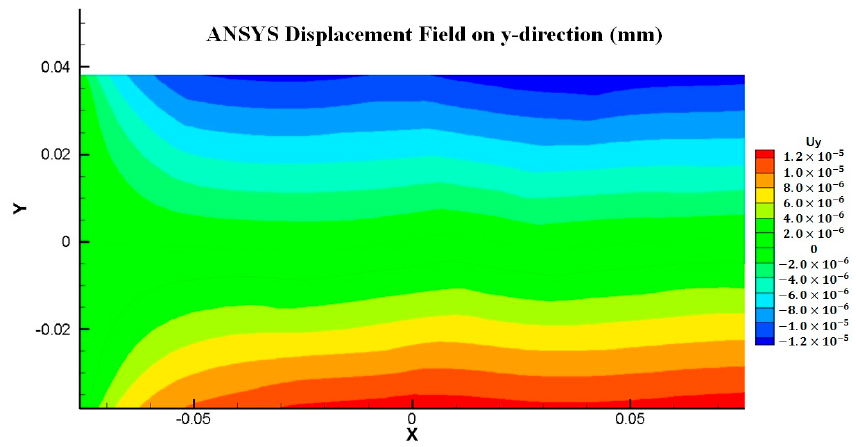
Figure 10. Displacement field comparison between FEM and PD analyses for Mo polycrystal (x-direction).